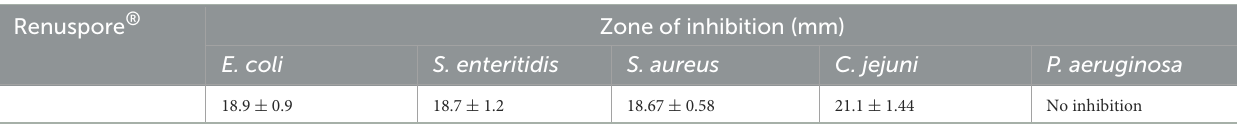
TABLE 3 Renuspore ® had moderate antimicrobial activity against E. coli, S. enteritidis, S. aureus , and C. jejuni in solid media